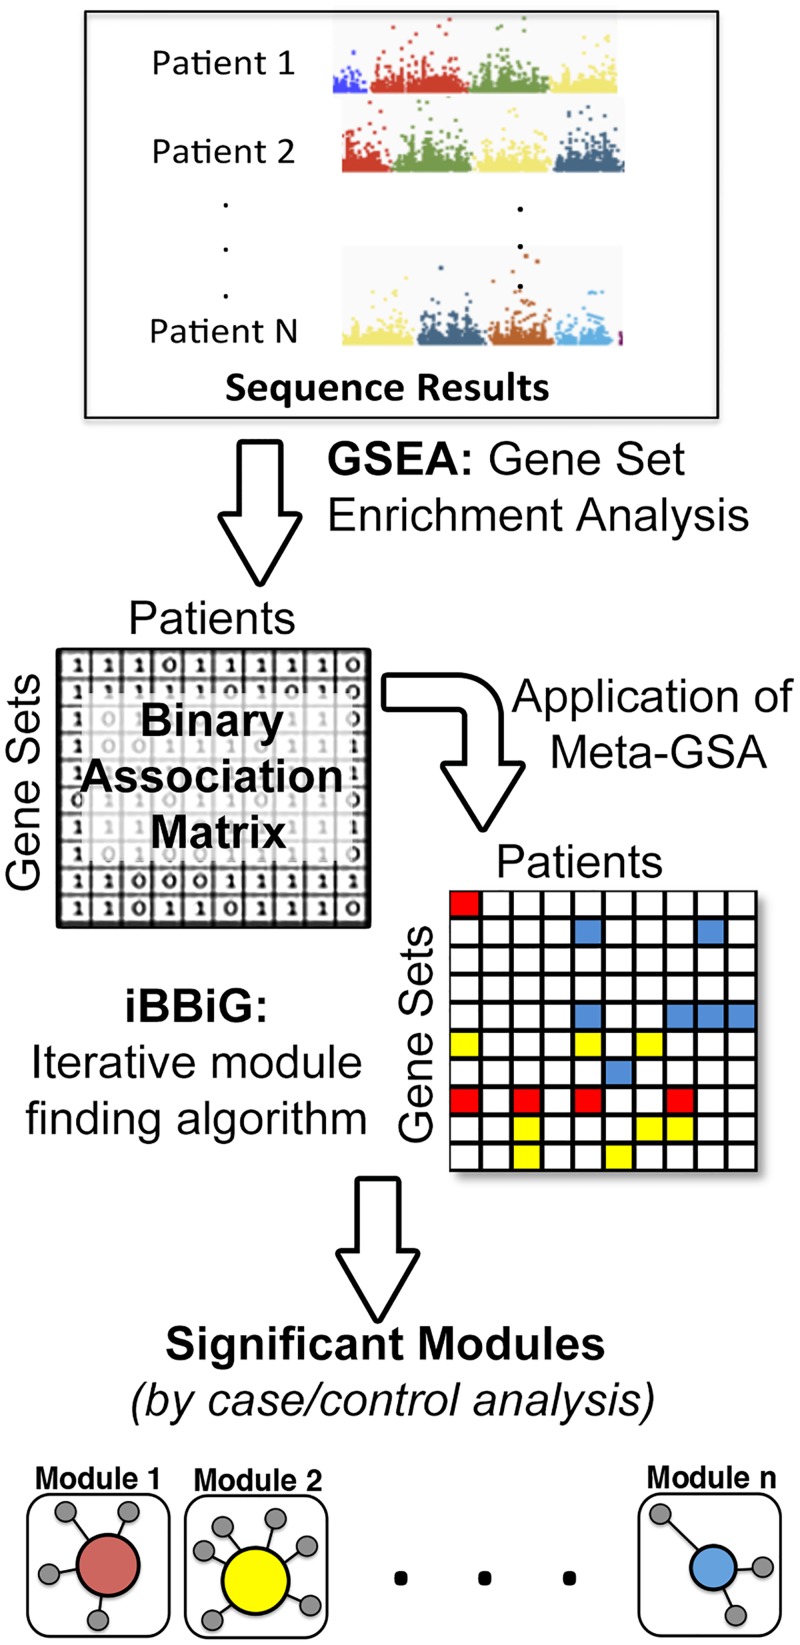
Meta-analysis and analytical pipeline:The genes harboring variants in each patient were analyzed by gene set enrichment using the MSig database C2 collection of gene sets [43]. The significant gene sets for each patient were combined into a binary association matrix. The iBBiG algorithm extracts modules of gene sets and patient subsets from the data matrix. The modules are represented by different colors. Fisher’s exact test was used to identify modules with significant differences in the number of cases and controls.